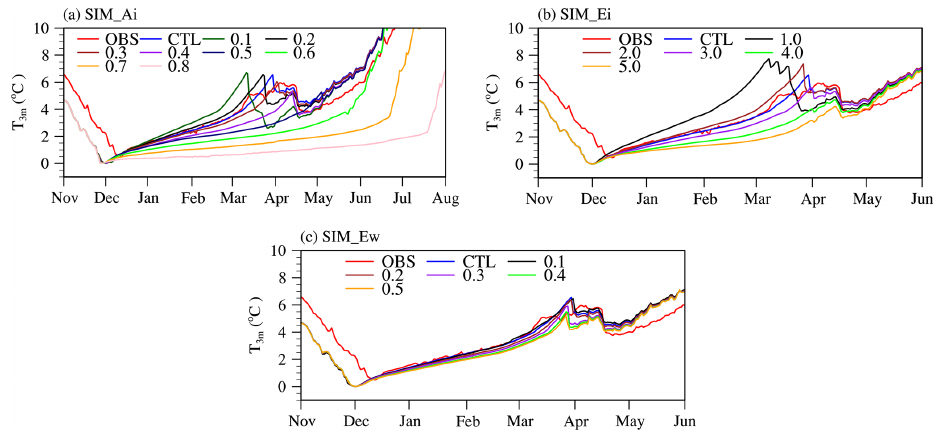
Figure 6. Comparison of the 3m simulated daily average water temperature with the observed value under different (a) A i , (b) E i , and (c) E w .